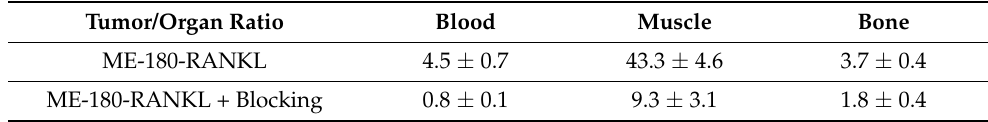
Table 1. Tumor-to-organ ratio of [ 89 Zr]Zr-DFO-AMG162 5 days post injection in mice bearing ME- 180-RANKL blocked ( n = 5) and non-blocked ( n = 5) xenografts. Data is shown below as mean ± the standard